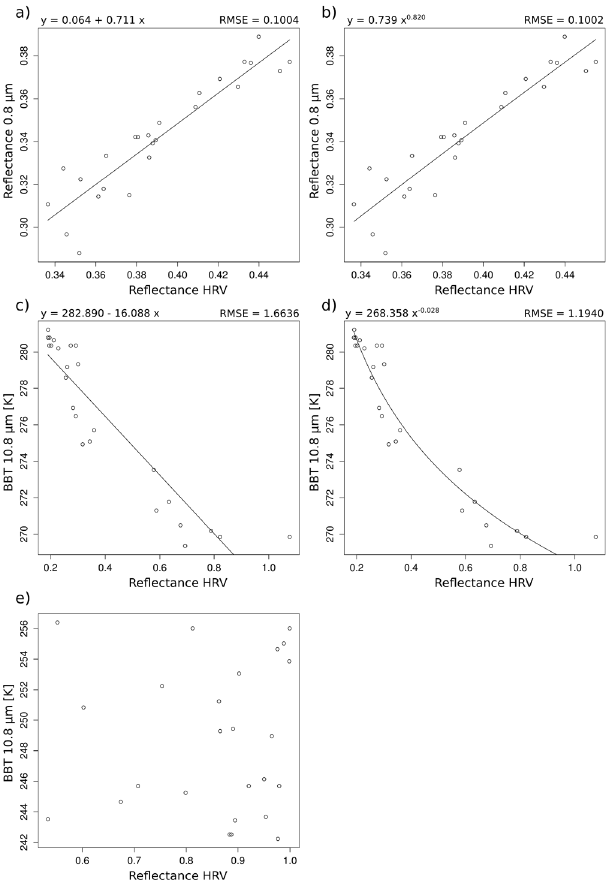
Fig. 5. Types of relationships between different narrow-band chan- nels and the HRV channel for single windows in a SEVIRI scene from 30 September 2003. The relationship shown in the upper row can be described well by a linear (a) and a potential regression (b) . The relationship shown in the middle row is better described by a potential regression (d) than by a linear regression (c) , while the re- lationship shown in (e) cannot be explained by the HRV values at